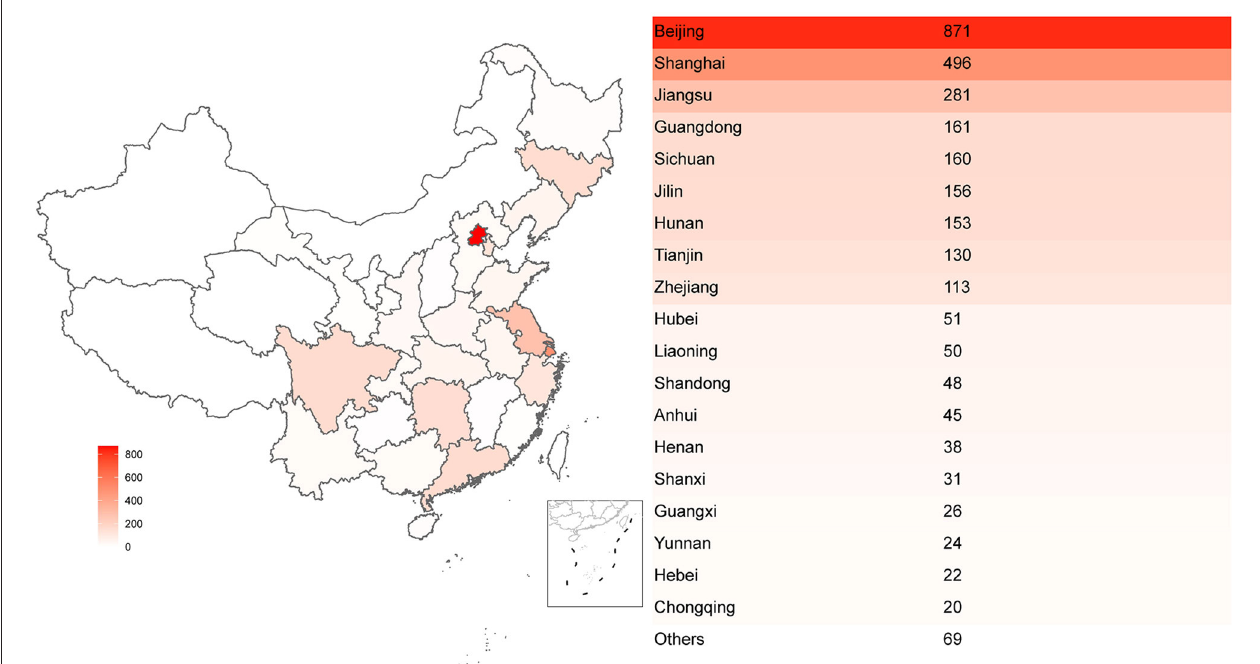
FIGURE 3 | Geographical distribution of phase I clinical trials during